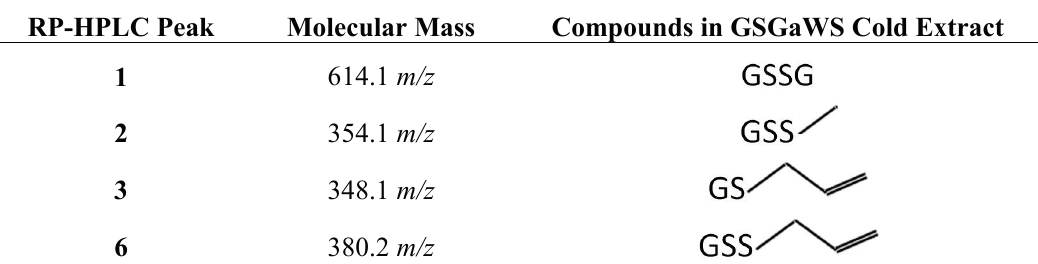
Figure 1. RP-HPLC of the water extracts obtained in the absence ( a , c ) or in the presence of GSH ( b , d ) obtained using low (a,b) and high (c,d) temperatures. The elution was performed with a linear gradient of 80% CH 3 CN, 0.1% TFA. Table 1. Molecular masses of the glutathionylated-compounds present in the GSGaWS cold